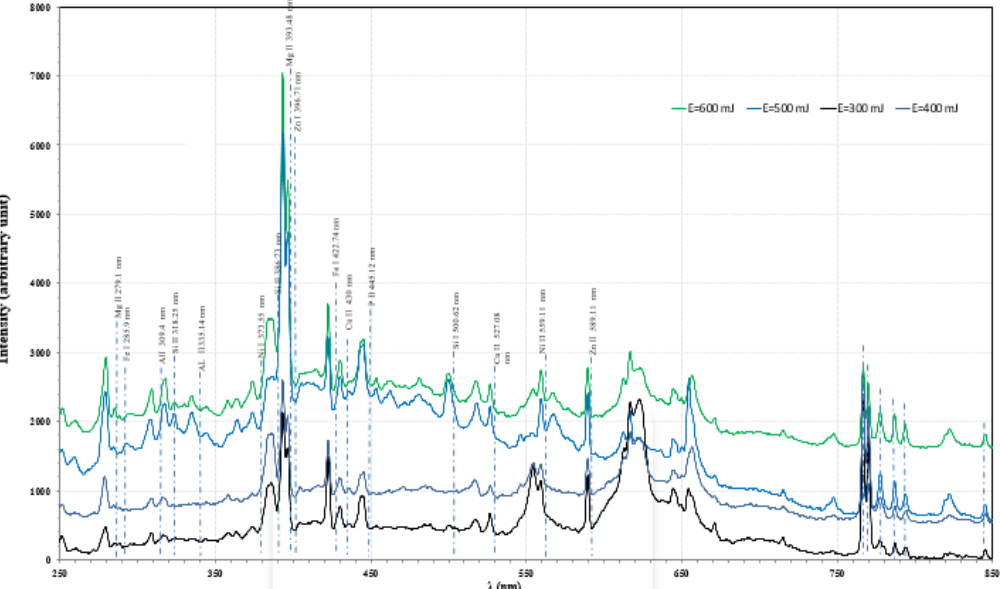
Figure 4: The Optical Emission Spectra for Indian Costus Plasma Produced in the Air with Different Laser